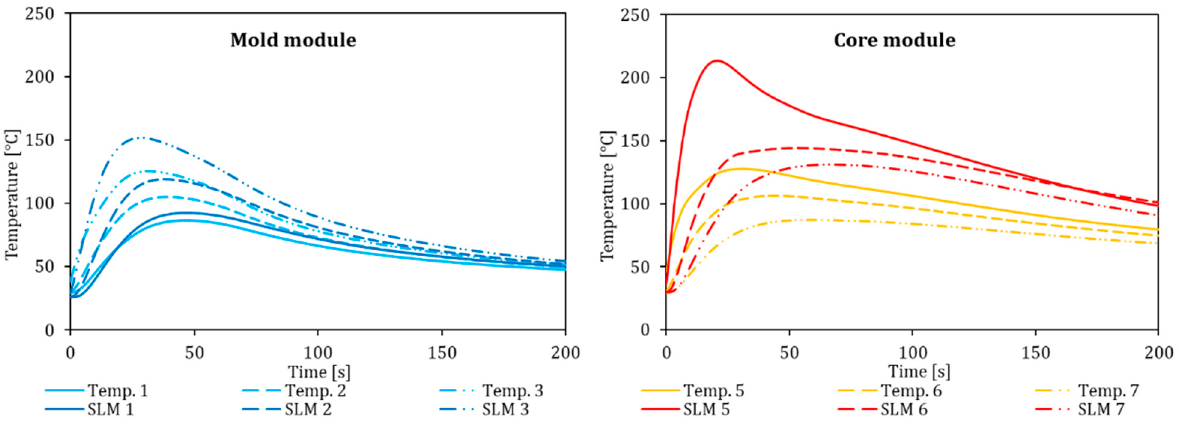
Figure 12. In-situ measured temperatures of casting experiments in the initial geometry and temperature control set to 30 °C.